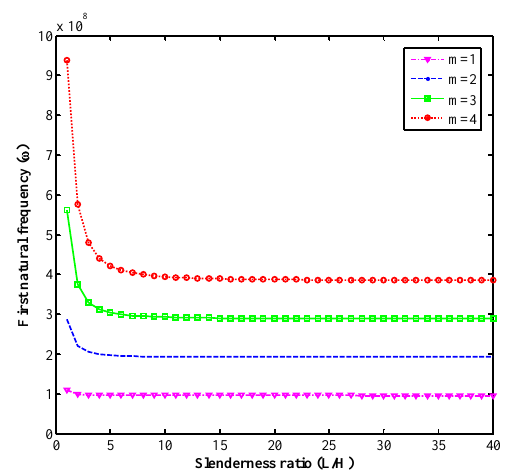
Fig. 3. The influence of axial wave number on the first natural